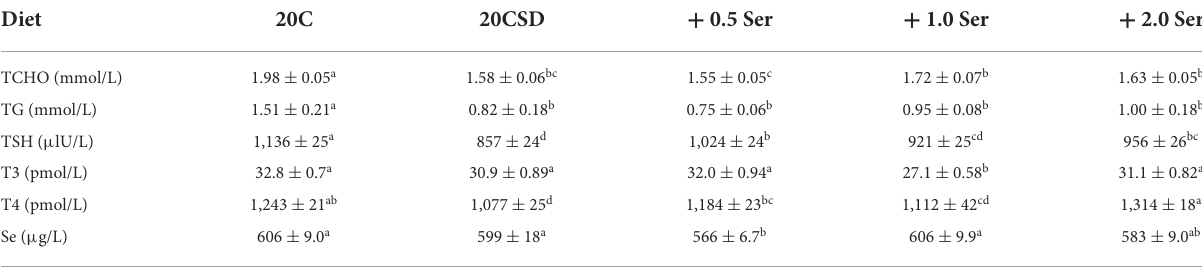
TABLE 2 Effects of supplementation of serine-deprived diet with serine (0.5, 1.0, and 2.0 times the amount of serine in 20C) on plasma Se concentration and other variables in rats fed a 20% casein diet (experiment 1).